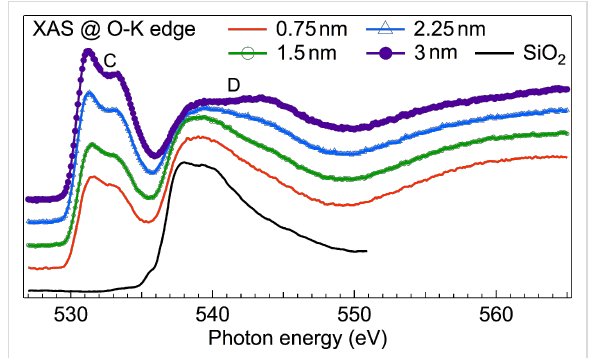
Figure 2: XAS at O-K edge measured for TiO 2 films with thicknesses of 0.75 nm, 1.5 nm, 2.25 nm and 3 nm. The XAS of native SiO 2 is also shown as reference. Spectra were normalized to the same intensity at 580 eV and vertically offset.